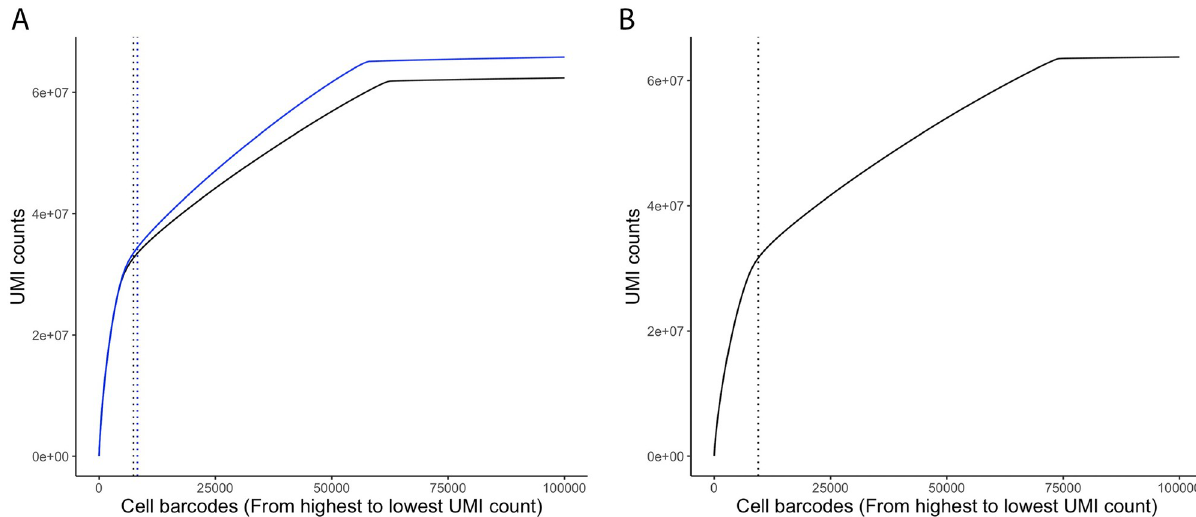
Fig 3. Identification of true nucleus-associated barcodes. Cumulative UMI counts plot—nucleus-associated barcodes, arranged in decreasing order (from highest to lowest UMI counts) versus the cumulative UMI counts. The vertical dotted lines indicate the 1,000 UMI-tagged transcripts cutoff. Nucleus barcodes with at least 1,000 UMIs were considered true nucleus. (A) Whole stem from biological replicate 1 and 2 (black and blue lines, respectively) of Populus trichocarpa . (B) Shoot apical meristem of Populus tremula × alba